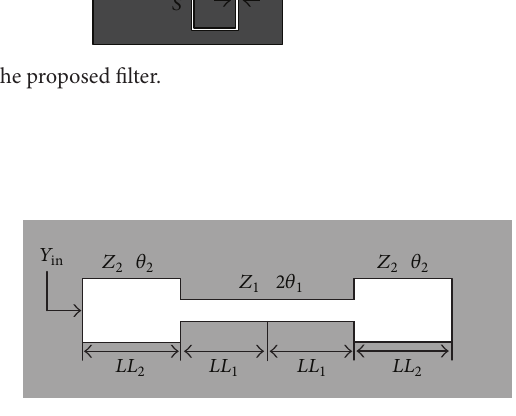
feed lines. The coupling between microstrip feed lines and